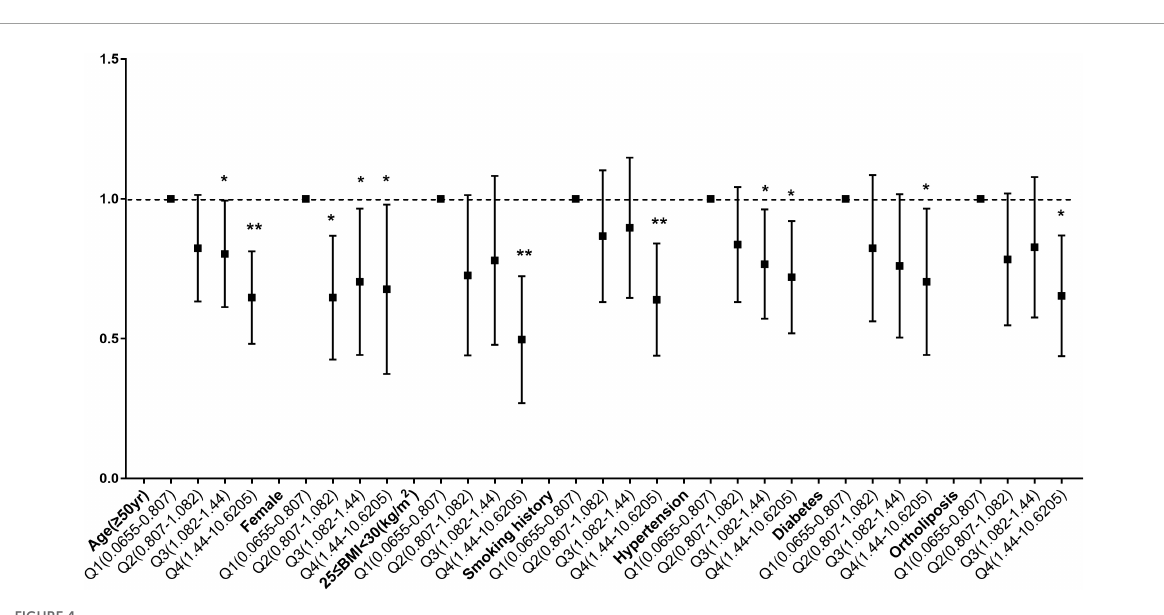
ratios of 0.63 (0.49, 0.82) and 0.68 (0.51, 0.91) before and after matching ( Supplementary Table 2 ). Likewise, female